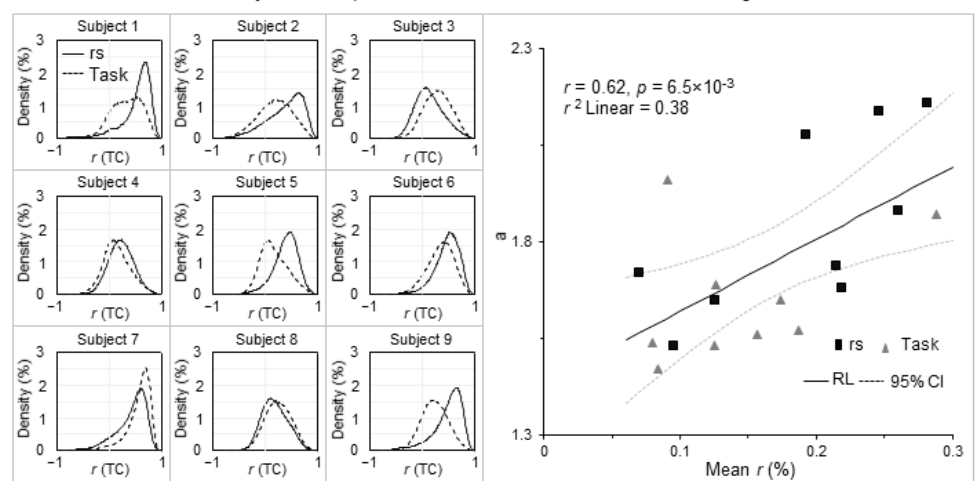
Figure 3. The distribution density of the temporal correlation (TC) r of paired FAUPAs for each brain